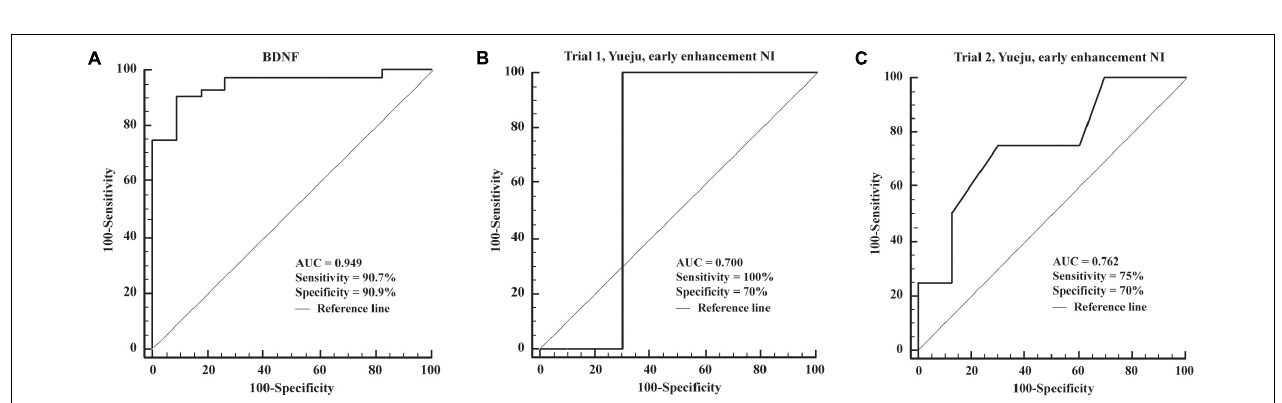
FIGURE 6 | Receiver operating characteristic curves of the detection power of different markers. (A) ROC curves of the detection of BDNF. (B,C) ROC curves of the detection of the biomarker of early NI enhancement in Trial 1 and Trial 2.